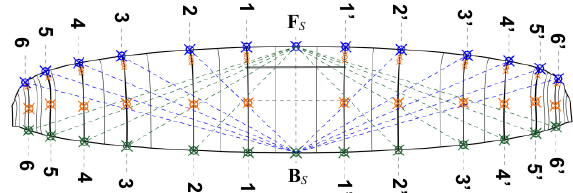
Fig. 9: Overview of the analyzed